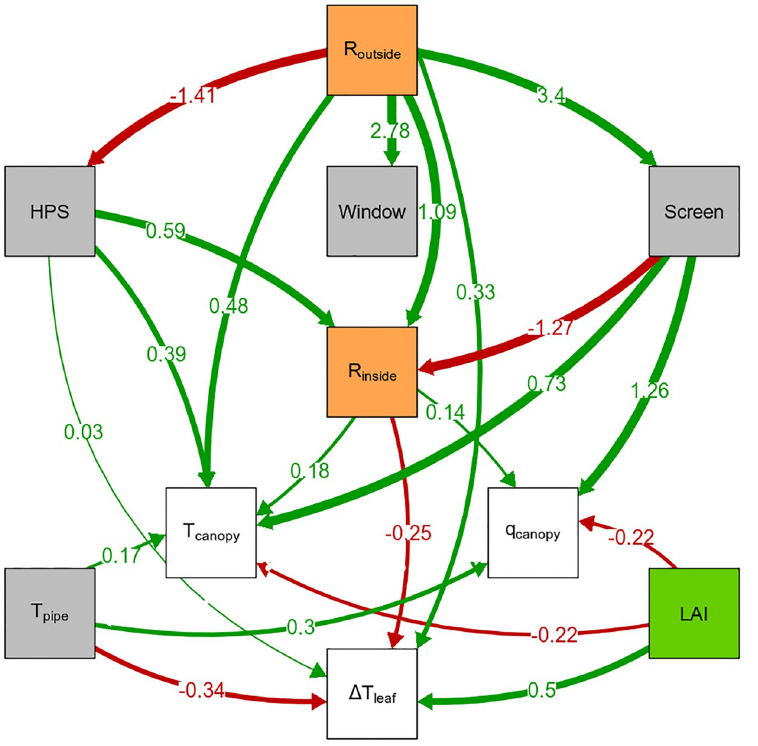
Fig 8. Causal path model for the difference between canopy air and leaf temperature. Causal path model that was consistent with the data (p = 0.062, df = 32, Fisher’s C = 45.15), where arrows show a causal relation of standardised path coefficients (values at arrows). The colour of the boxes denote the following: white represents the climate variables, grey represents the climate control measures, green represents the crop and orange represents radiation. For the complete diagram see S8 Fig. Abbreviations: R outside is outside global radiation; R inside is inside global radiation; HPS is High Pressure Sodium lamps, supplemental assimilation lighting; Window is window opening (open or closed); Screen is shading screen position (open or closed); T pipe is temperature of the heating pipe; LAI is leaf area index; T ambient is ambient temperature, temperature above canopy; q ambient is ambient absolute humidity, absolute humidity above canopy ; Δ T leaf is difference between canopy air temperature and leaf temperature. Also see Table